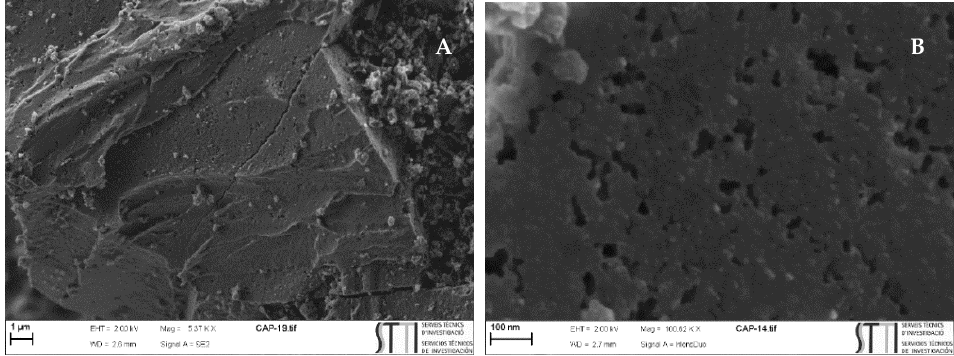
Figure 1. SEM images of PAC at di ff erent scales: ( A ) 5370 magnification. ( B ) 100,620